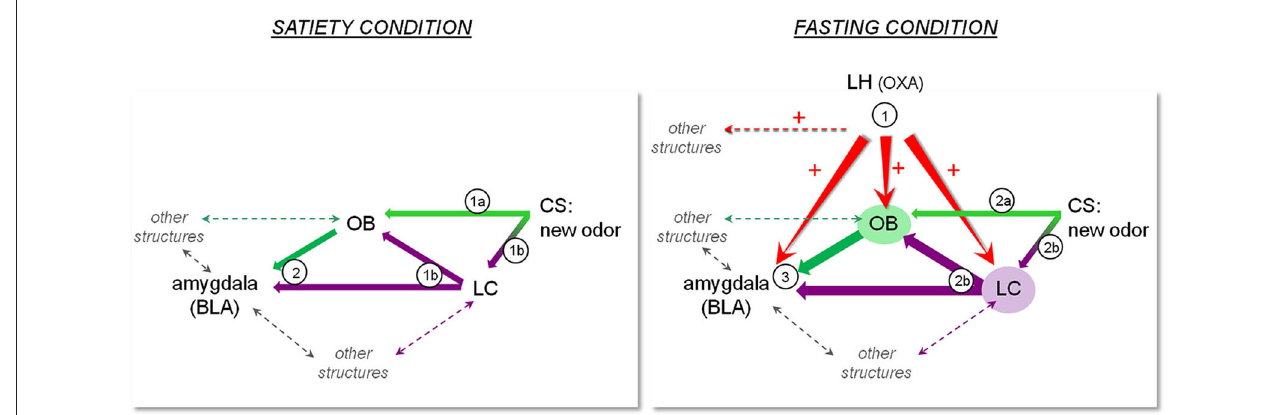
olfactory CS in the fasting condition. Fasting induces release of OXA in the OB, BLA and LC, preparing the system to respond to any food-odor event. 2a) Olfactory CS induces activation of the OB, potentiated by activation of the OXA system and LC-mediated NA system in the OB. In the fasting condition, CS leads to improved olfactory detection and processing. 2b) The novelty of the olfactory CS induces LC activation, resulting in enhanced NA release in the OB and BLA. 3) The enhanced olfactory information is transmitted to the BLA. Combined with OXA system activation, LC-mediated NA release in the BLA and potentiated OB activation, the olfactory memory trace strengthened or lengthened, and can thus be associated to a delayed US. This sequence of events results in COA when a long ISI is